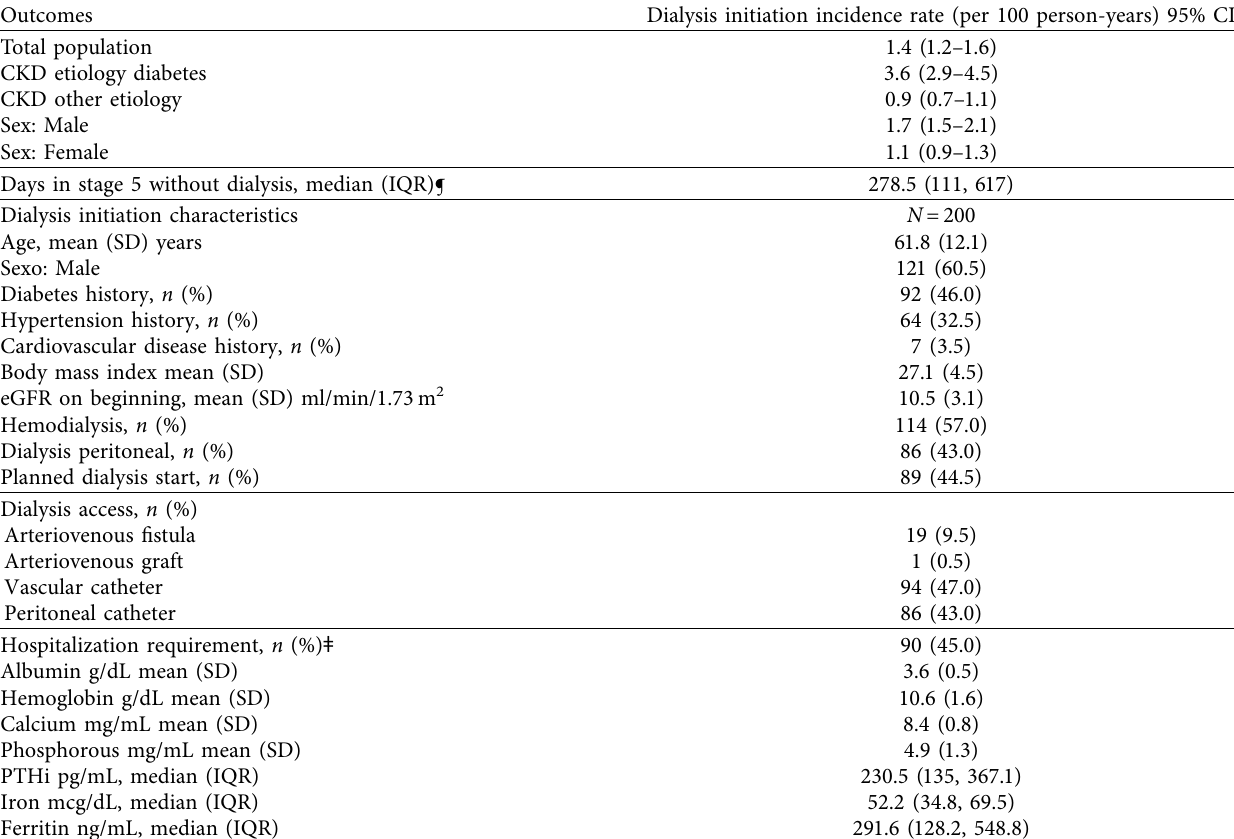
Table 2: Outcomes and baseline characteristics of the population dialysis